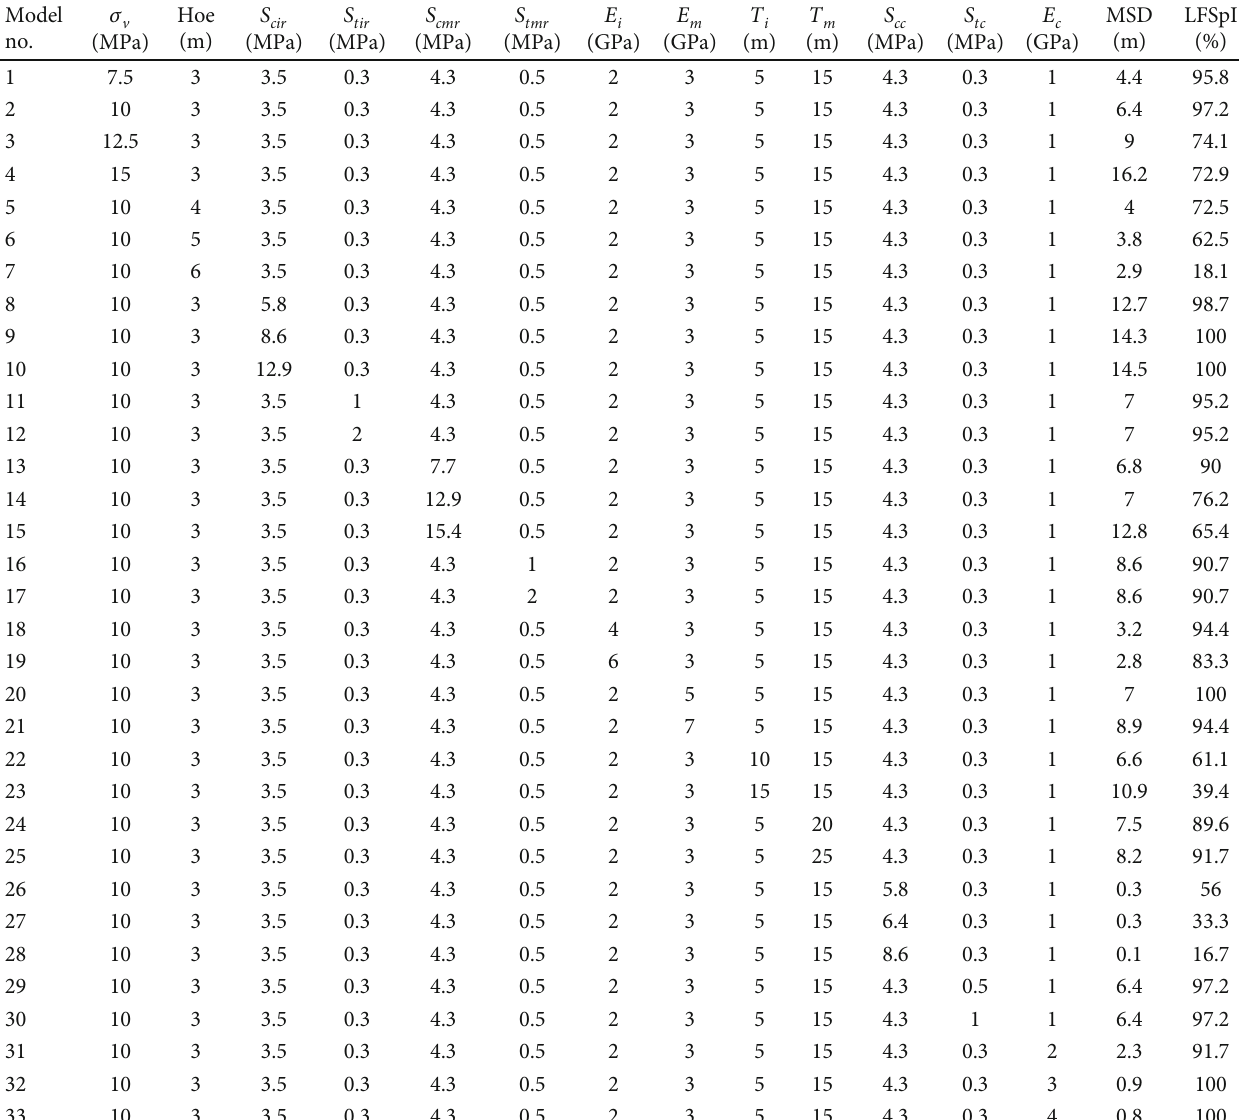
Table 4: Experimental design and summary of parametric